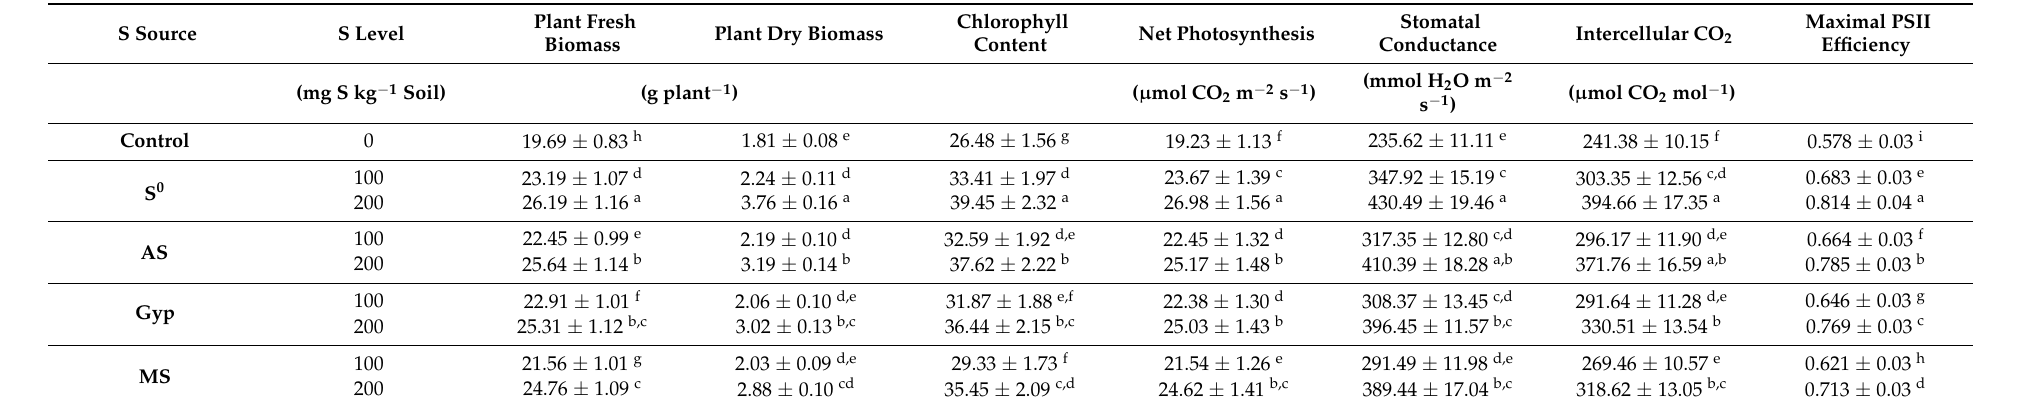
Table 3. Plant fresh biomass, plant dry biomass, chlorophyll content (SPAD values), net photosynthesis, stomatal conductance, intercellular CO 2 and maximal PSII efficiency ( F v /F m values) of Brassica juncea cv. Giriraj grown under three S levels [i.e., control 0S (0 mg S kg − 1 soil), 100S (100 mg S kg − 1 soil) and 200S (200 mg S kg − 1 soil)] and four S sources [i.e., elemental S (S 0 ), ammonium sulfate (AS), gypsum (Gyp) and magnesium sulfate (MS)]. Data are presented as means ± SE ( n = 4). Data followed by same letter within columns are not significantly different by LSD test at p < 0.05. S,